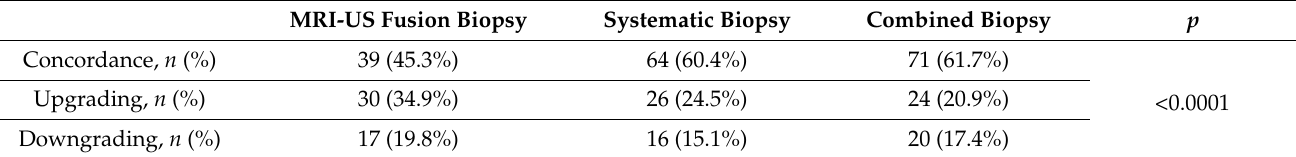
Table 2. Concordance rates between GG of MRI-US fusion prostate biopsy and radical prostatectomy specimen.